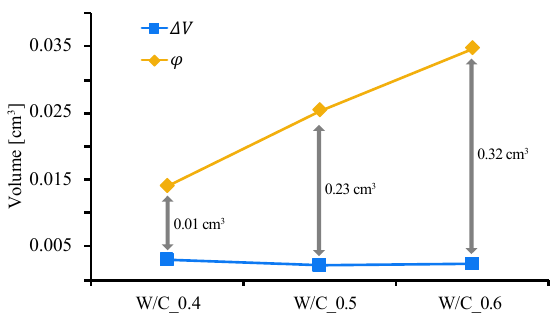
Figure 9. Relationship between W/C ratio, volume increase due to carbonation ( ∆𝑉 ), and closed pore volume ( 𝜑 ).